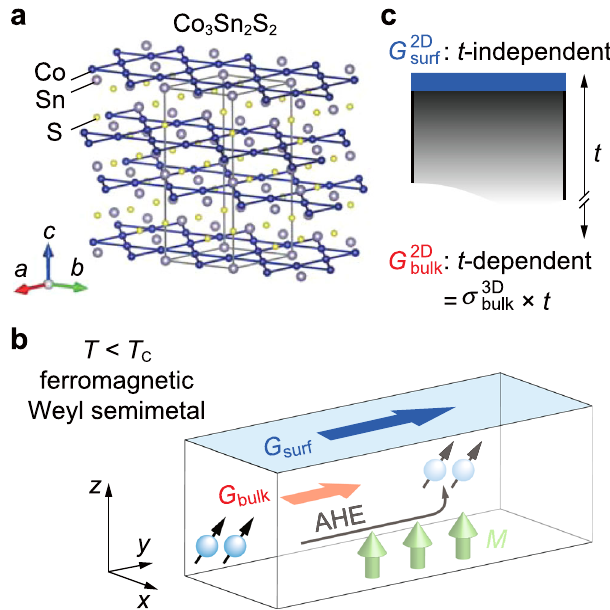
Fig. 1 Electrical conduction in Weyl semimetal Co 3 Sn 2 S 2 thin fi lms. a Crystal structure of Co 3 Sn 2 S 2 . b Concept of electrical conduction of Co 3 Sn 2 S 2 thin fi lms in the bulk G bulk and at the surface G surf . Below Curie temperature, perpendicular magnetization M (green arrows) induces anomalous Hall effect (AHE). c Cross-section of thin fi lms with thickness t -dependent G 2D and t -independent G 2D . Sheet conductance in the bulk bulk surf G 2D is evaluated by three-dimensional conductivity of bulk Co 3 Sn 2 S 2 bulk σ 3D × t bulk